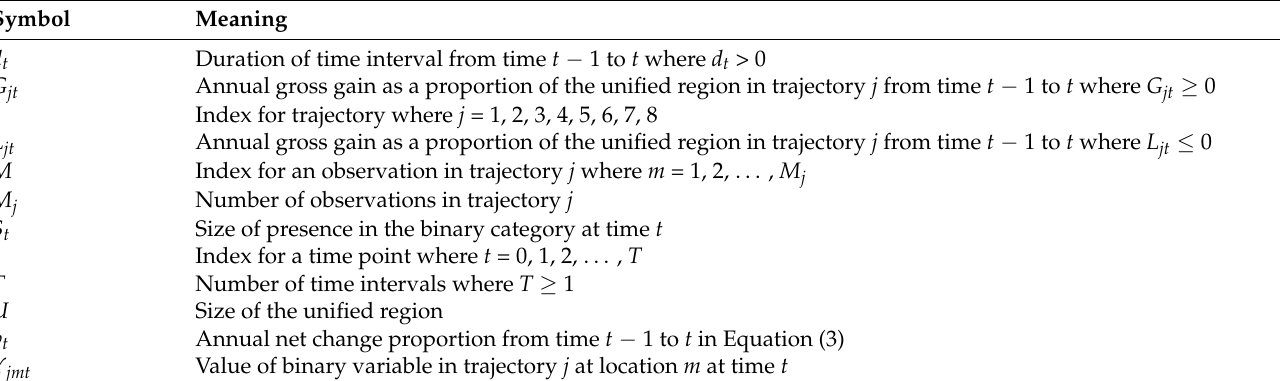
Table 2. Mathematical notations for